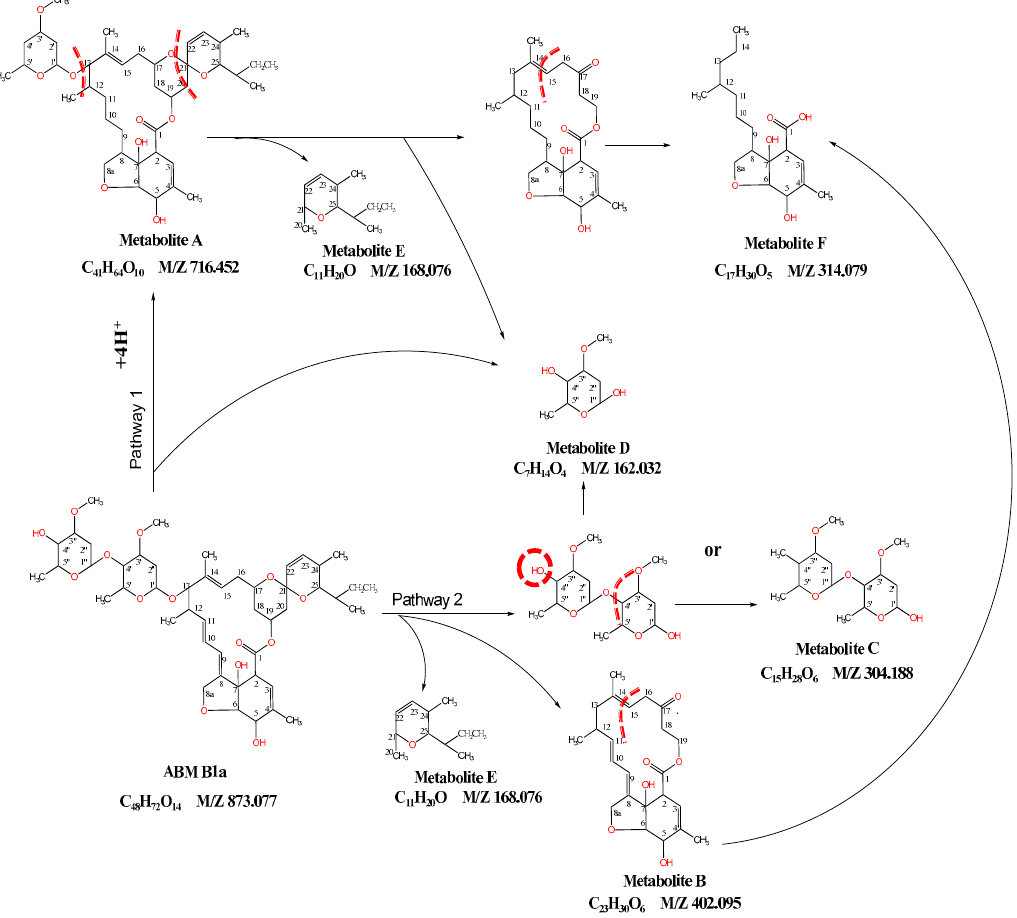
Figure 5 . Possible biodegradation pathways of strain B. sp LM24 to ABM .